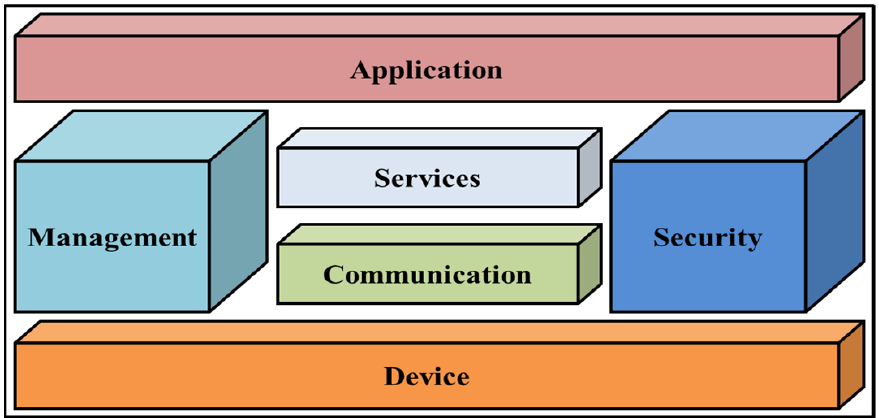
Figure 3. Main functional blocks of IoT.